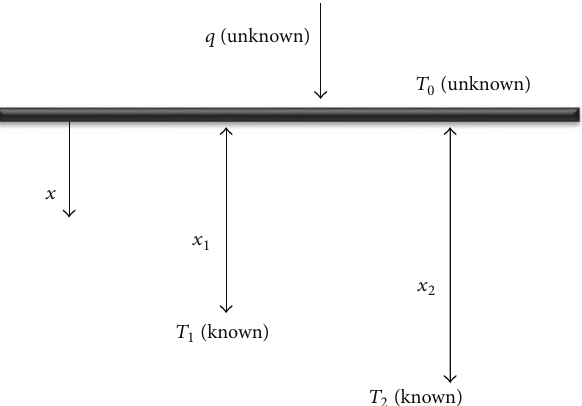
Figure 3: Schematic of applying IHCP to deduce interfacial heat fluxes for the single belt strip casting